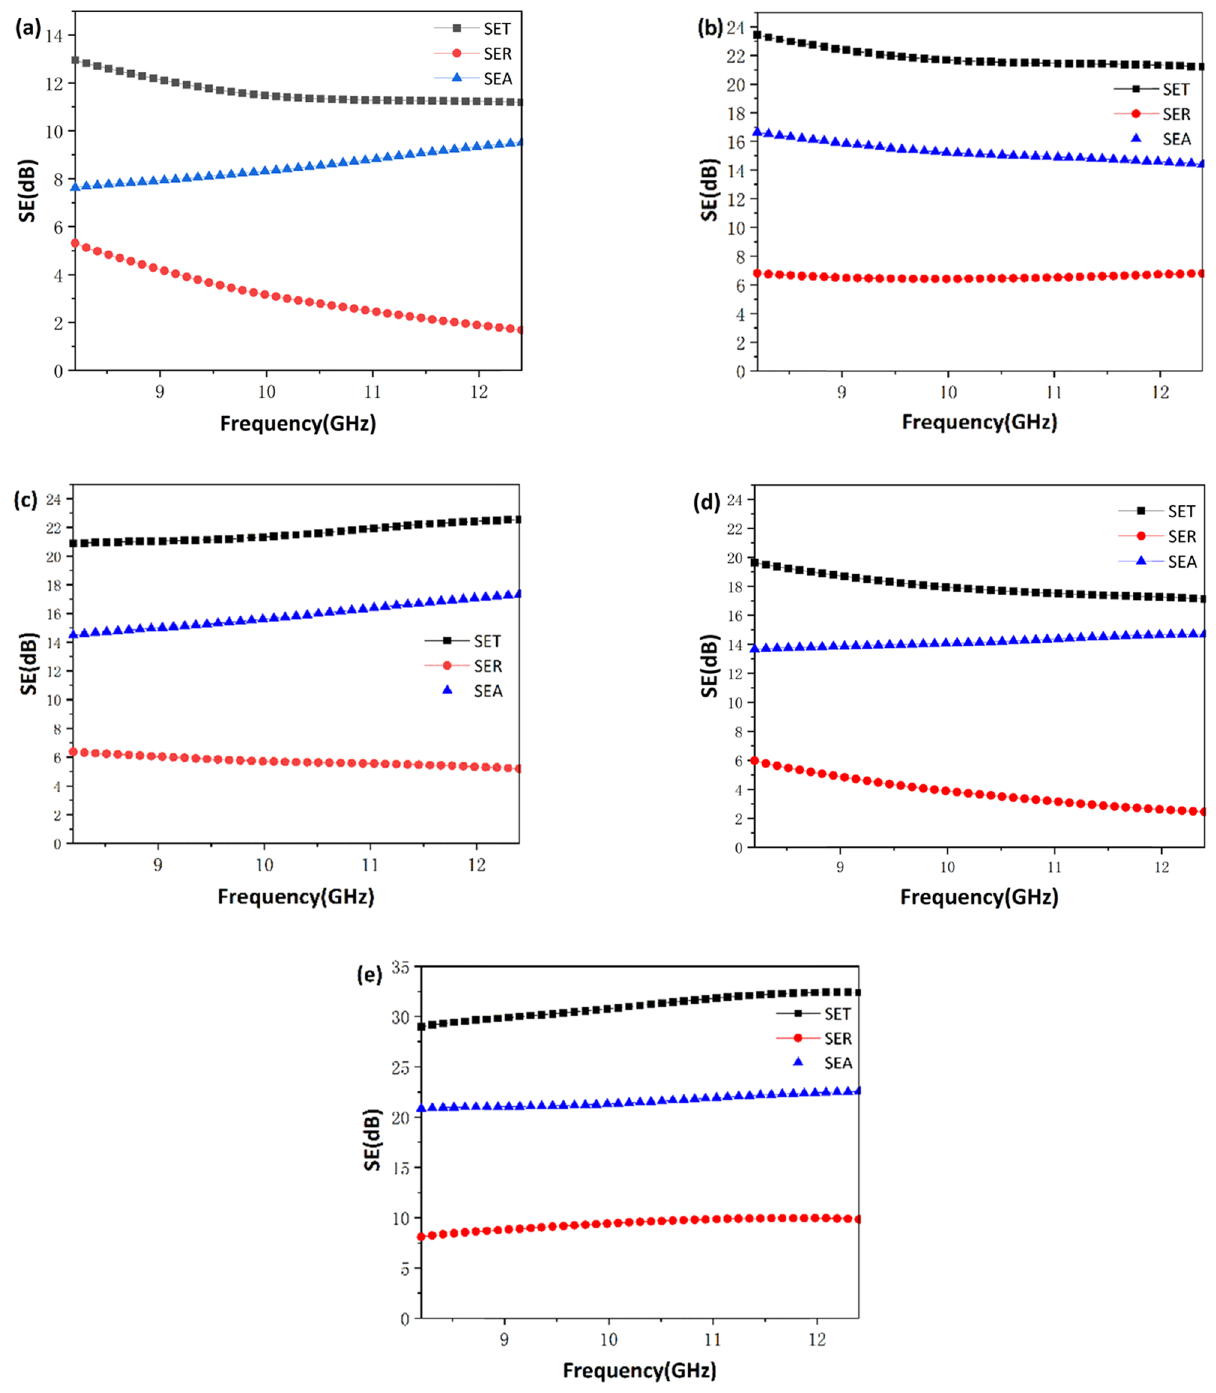
Figure 4: SE of: ( a ) MWCNT/foam - 20, ( b ) MWCNT/foam - 40a, ( c ) MWCNT/foam - 40b, ( d ) MWCNT/foam - 40c, and ( e ) MCHMs/MWCNT/foam -